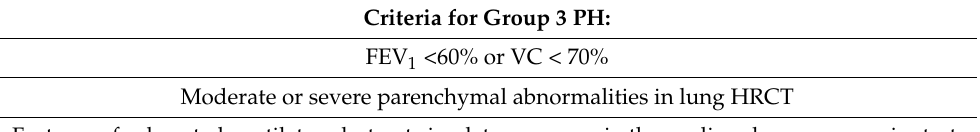
Criteria for Group 3 PH: